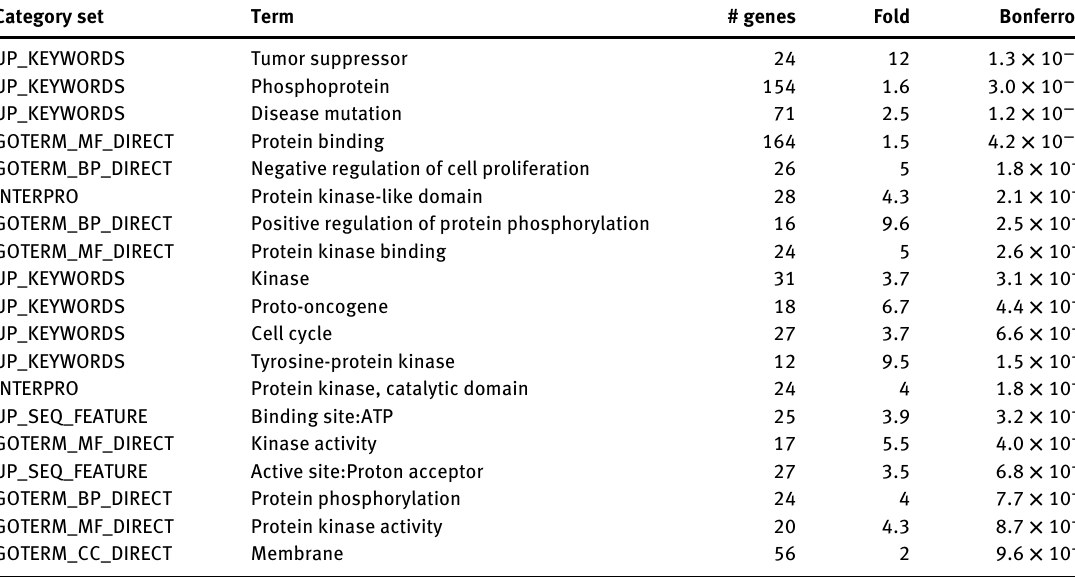
Table 1: Categories of gene ontologies for glioblastoma genes according to DAVID Category set Term # genes Fold